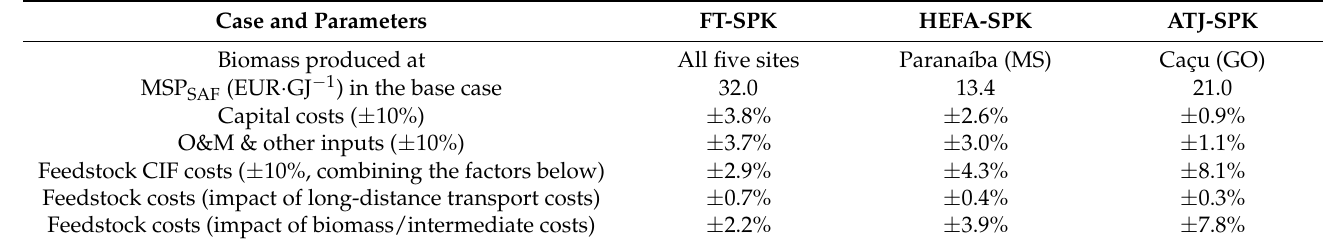
Table 5. The sensitivity analysis results in relation to the MSP estimates in the base case for the three routes considered. Case and Parameters FT-SPK HEFA-SPK ATJ-SPK Biomass produced